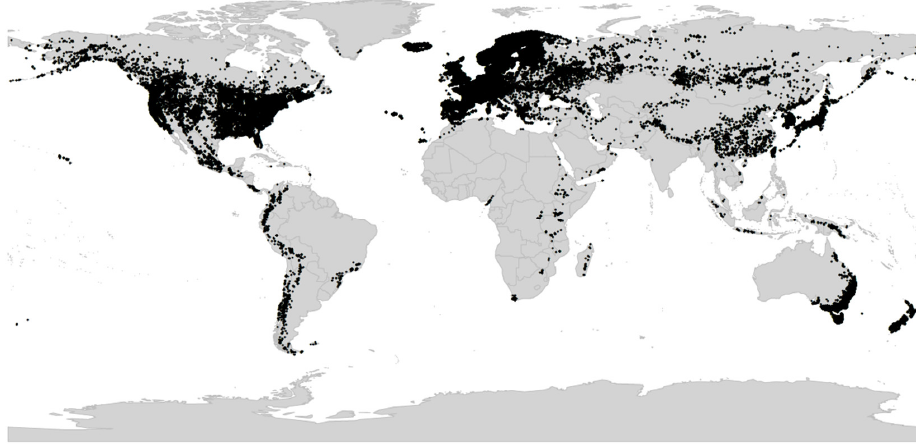
Figure 2. Global distribution of Viola L. (Violaceae), showing the predominantly temperate distribu- tion of the genus.